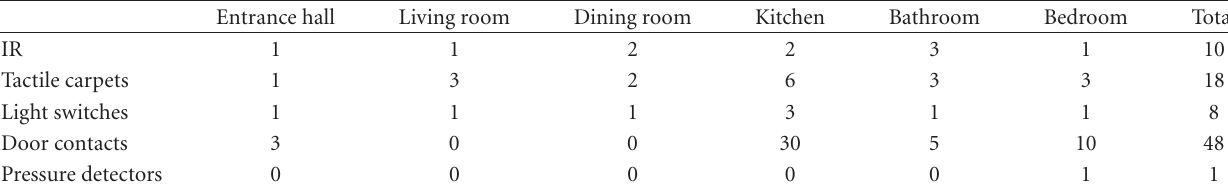
Table 1: List of sensors per room.